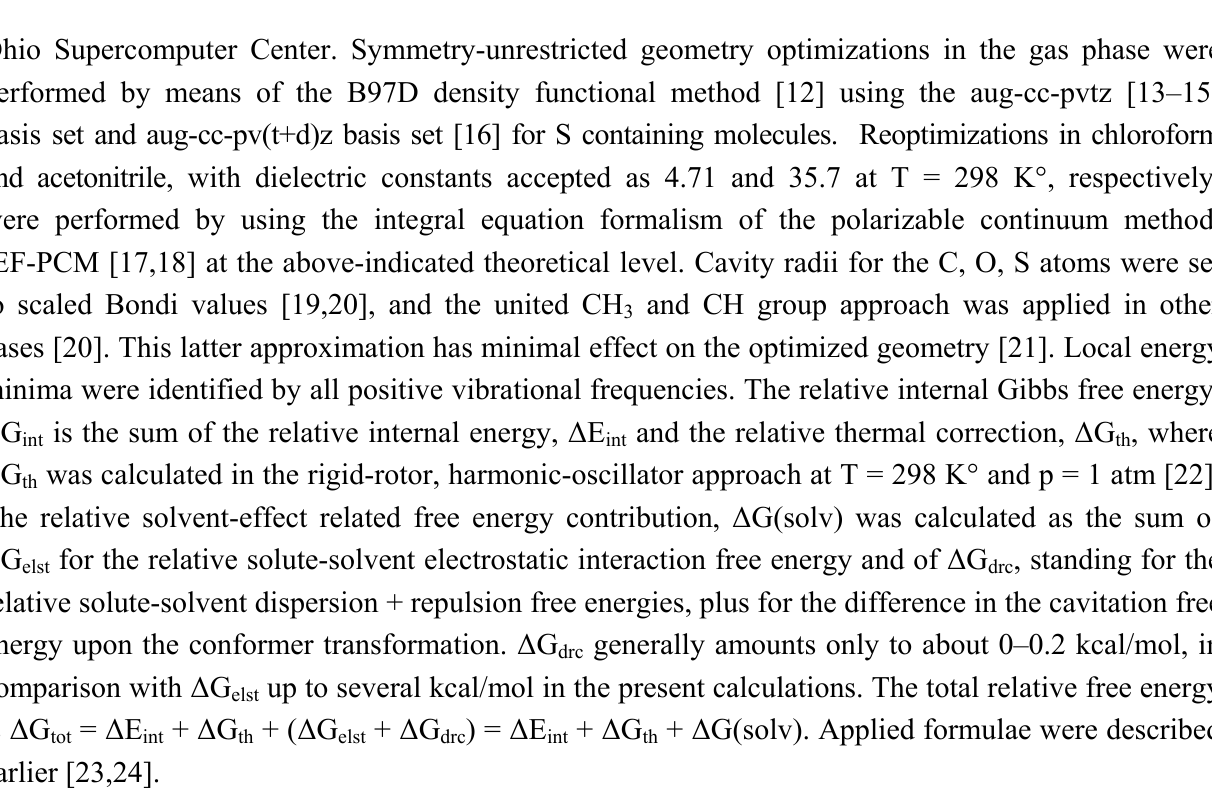
Figure 1. Compound structures: methyl acetate ( 1 ); S-methyl thioacetate ( 2 ); O-methyl thioacetate (O-methyl ethanethioate, 3 ); dithioacetic acid methyl ester ( 4 );